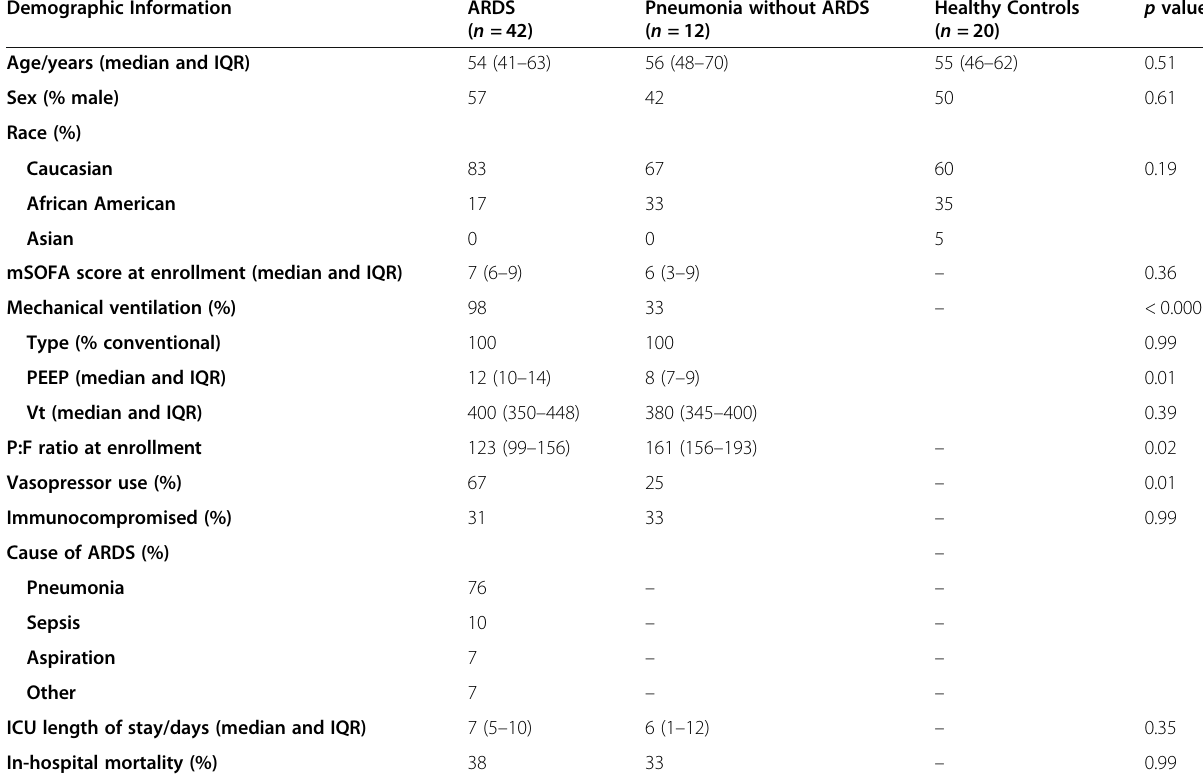
Table 1 Characteristics of study subjects Demographic Information